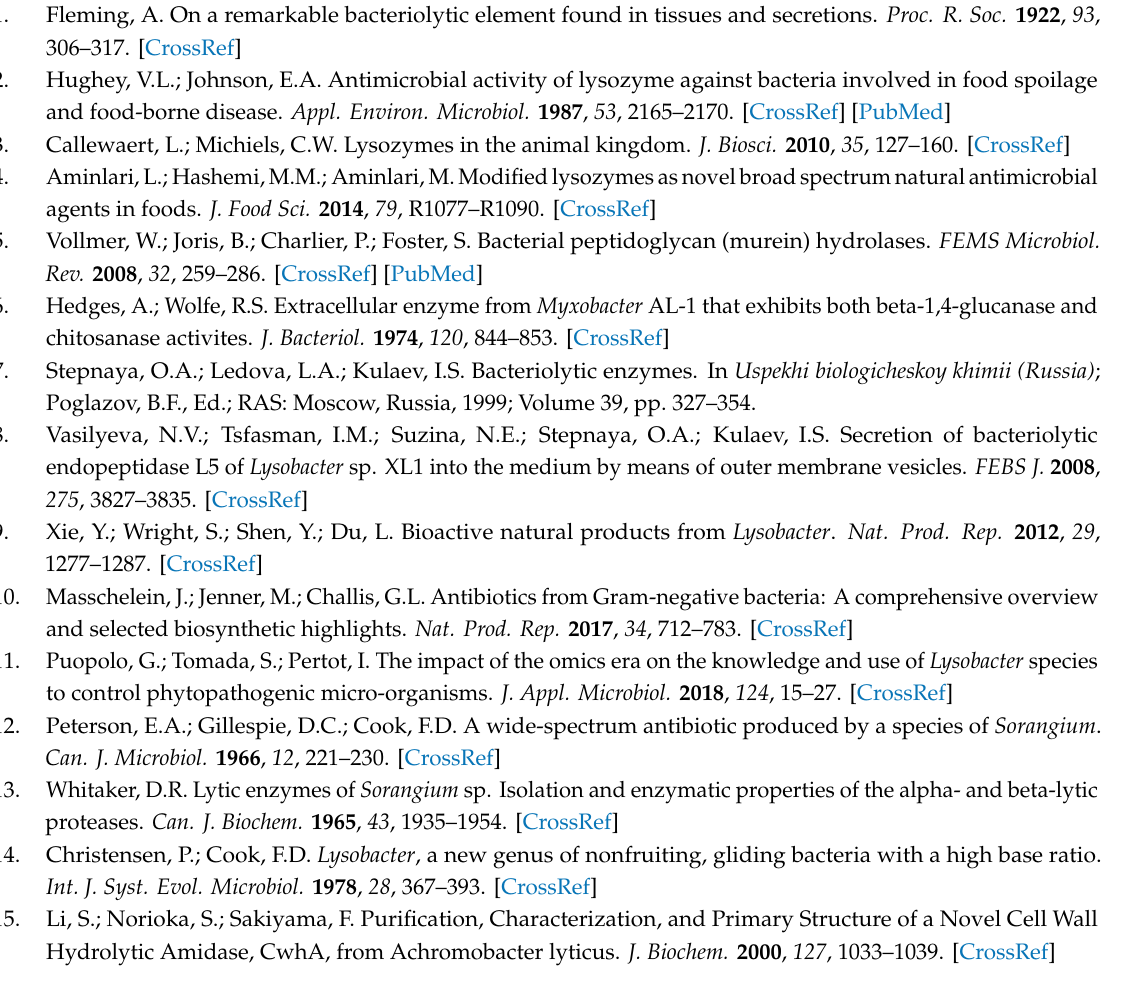
Figure S1: Dependence of the bacteriolytic activity of the BlpLc on some factors. (a) Temperature; (b) ionic strength; (c) pH; (d) pH stability; (e) temperature stability. Values represent means ± standard deviations of three independent measurements. Figure S2: The type of bond hydrolyzed by the BlpLc in different substrates. (a) Bovine hemoglobin, A-chain; (b) bovine hemoglobin, B-chain; (c) horse myoglobin; (d) ovamucoid; (e) ovalbumin. Arrows, bonds hydrolyzed by the